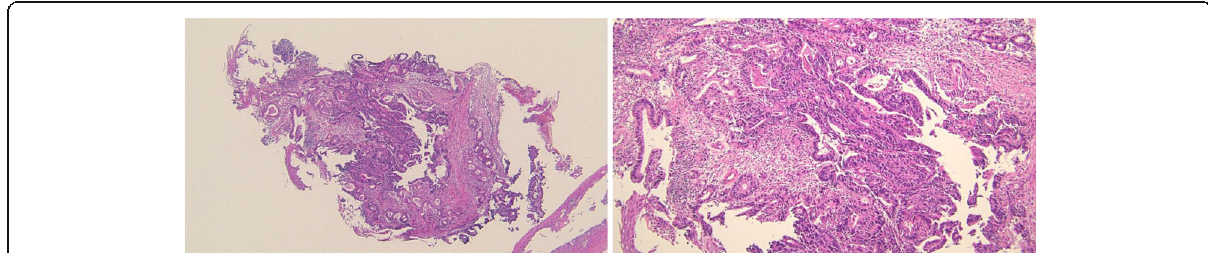
Fig. 3 Histopathological examination of an endoscopic biopsy specimen showed proliferation of atypical cells with glandular structures, based on which the tumor was diagnosed as an adenocarcinoma